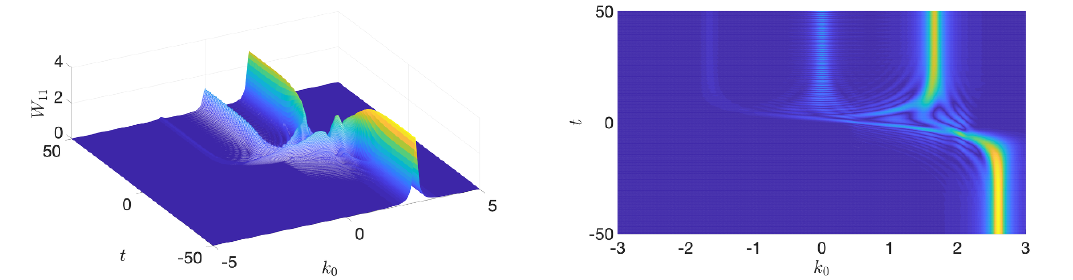
Figure 5. The same as in (cid:12)gure 4, but for parameters h = 1, j k j = 0 : 7, m 1R = 0 : 5, m 2R = 2, m I = (cid:0) 0 : 005, (cid:28) w = 5 and (cid:0) = 0 :